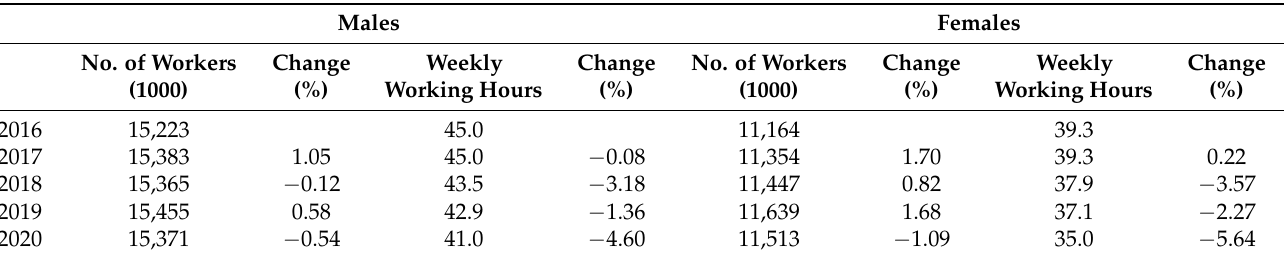
Table 8. Number of workers and weekly working hours for males and females in Korea (2016–2020). Males Females No. of